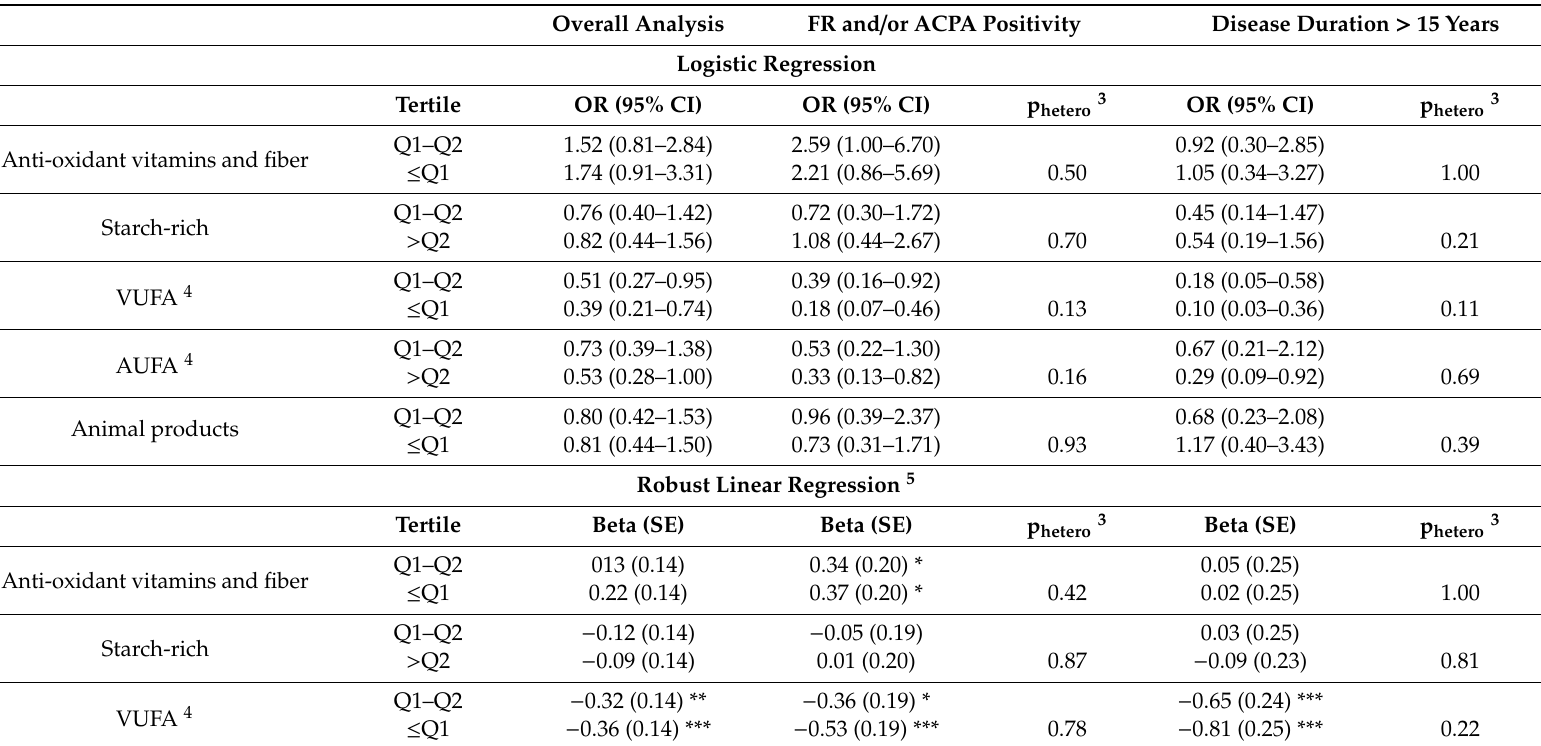
Table 3. Odds Ratios (ORs) of rheumatoid arthritis disease activity and corresponding 95% confidence Intervals (CIs) (upper panel) and increments in the mean DAS-CRP in continuous (lower panel), according to the highest tertile-based categories of consumption of five retained dietary patterns from a principal component factor analysis 1,2